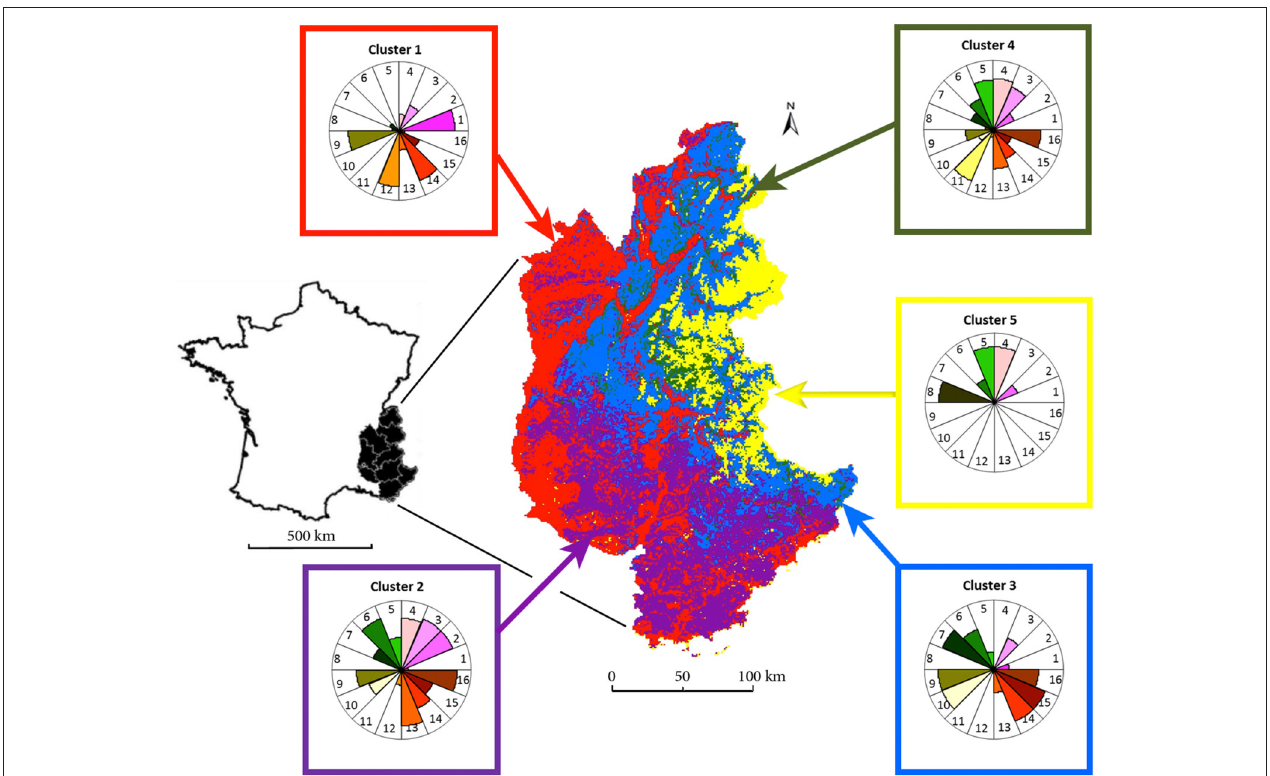
FIGURE 8 | Self-organizing map of the French Alps, with five clusters and related ecological profiles (values normalized to 0–1) (Modified from Crouzat et al.,